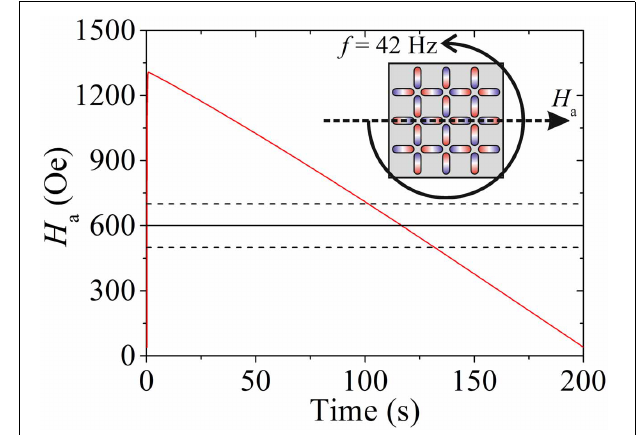
FIGURE 2 | Applied field protocol example. (Inset) A sample is rotated about an out-of-plane axis at f = 42Hz whilst and in-plane field H a is applied. H a is ramped down from 1300 to 0 Oe in a linear fashion, as shown in the main plot for a ramping rate of r = 6 Oe/s (red solid line). The black solid line indicates the coercive field of such samples, H c ≈ 600 Oe, and the dashed black lines indicate the estimated intrinsic macrospin switching field distribution width of ≈ ± 100 Oe centered about H c